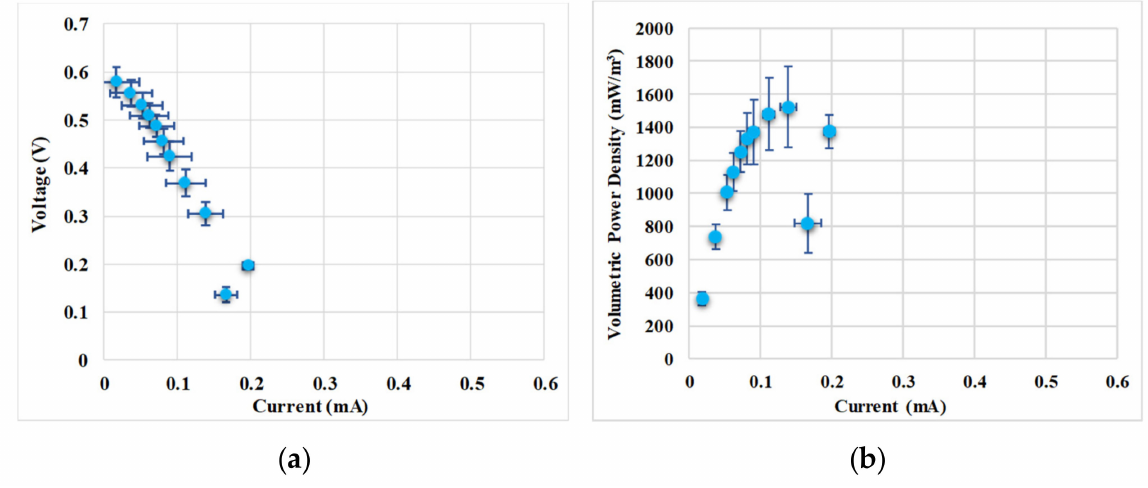
Figure 9. Single MFC performance: Polarization curve ( a ), volumetric power density curve ( b ).